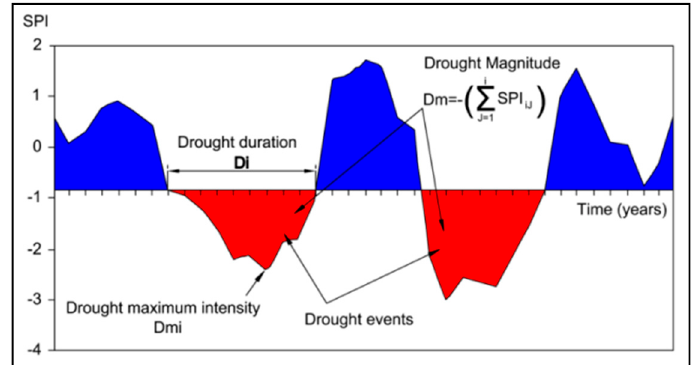
Figure 2. Definition of drought properties based on the SPI index [55].